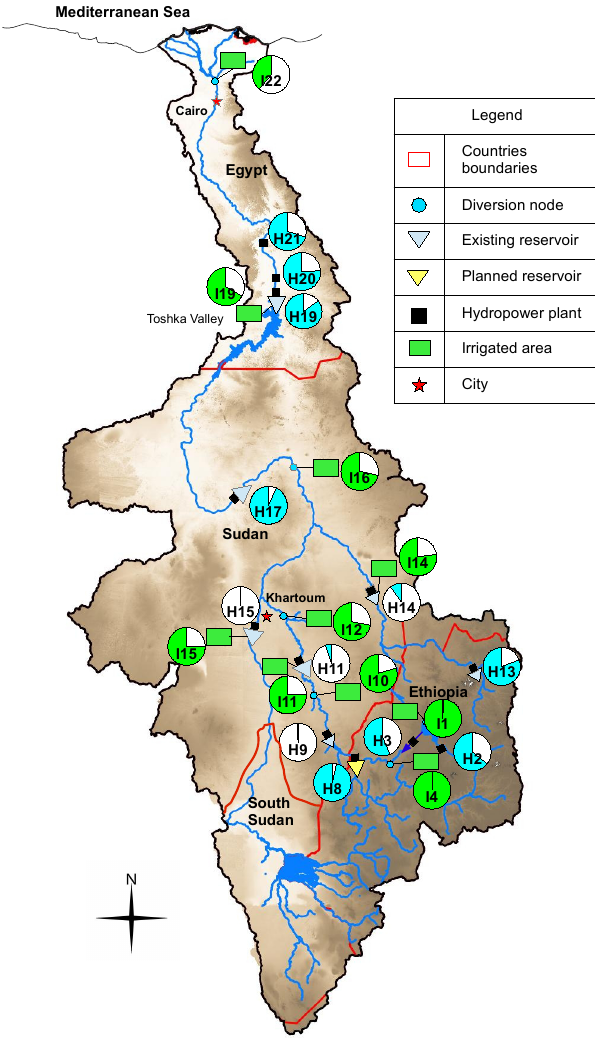
Figure 11. Percentage of unconstrained benefits claimed by